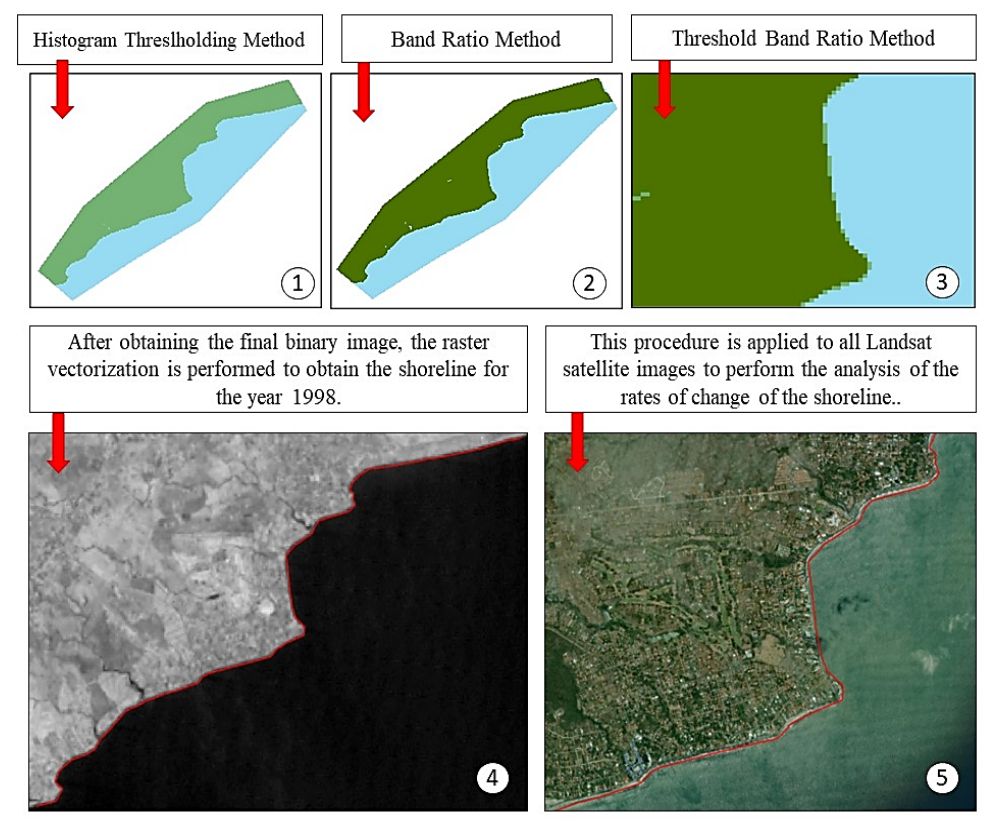
Figure 4. Automatic shoreline extraction